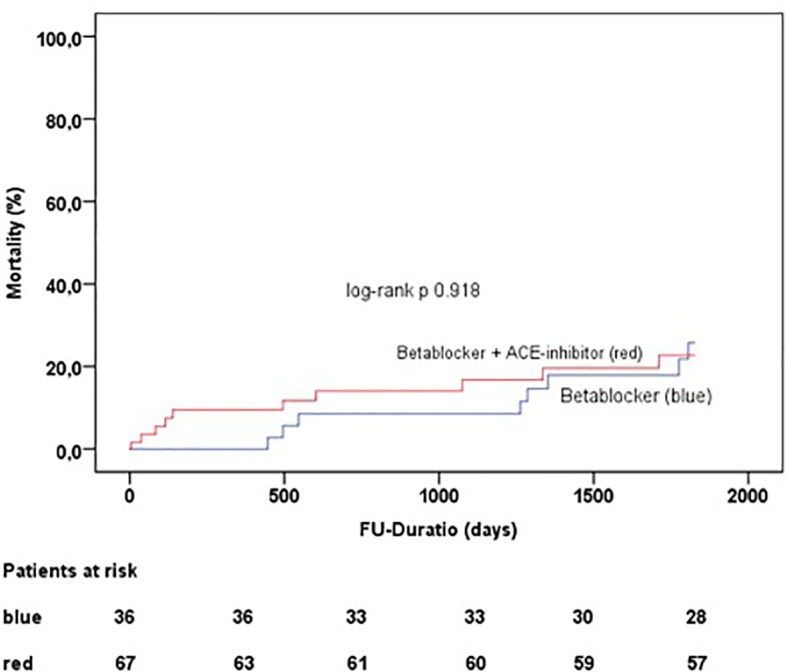
Follow-up duration and mortality in TTS patients treated with beta-blockers and angiotensin-converting-enzyme inhibitors and beta blocker single treatment.